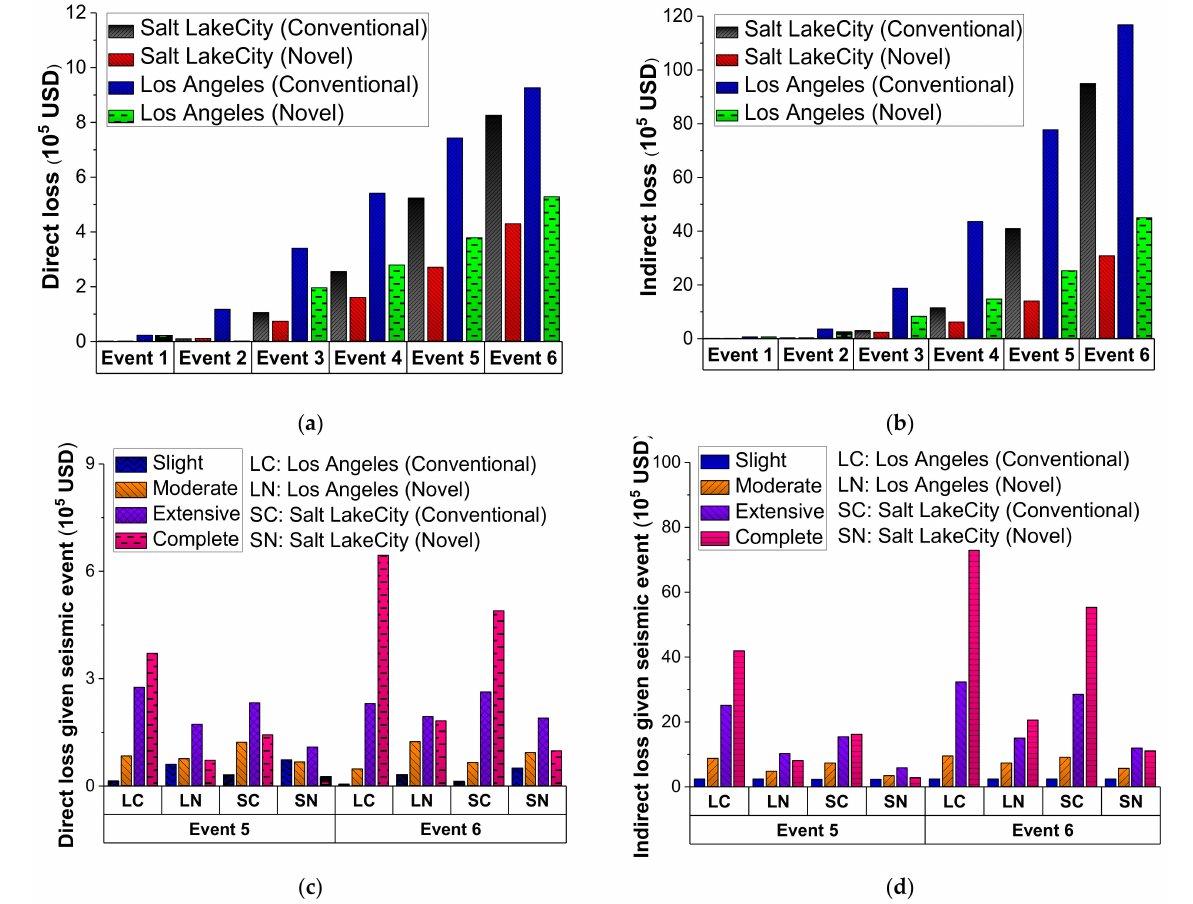
Figure 14. Predicted losses of bridges under different hazard events: ( a ) total direct loss, ( b ) total indirect loss, ( c ) direct loss under four damage states, and ( d ) indirect loss under four damage states.